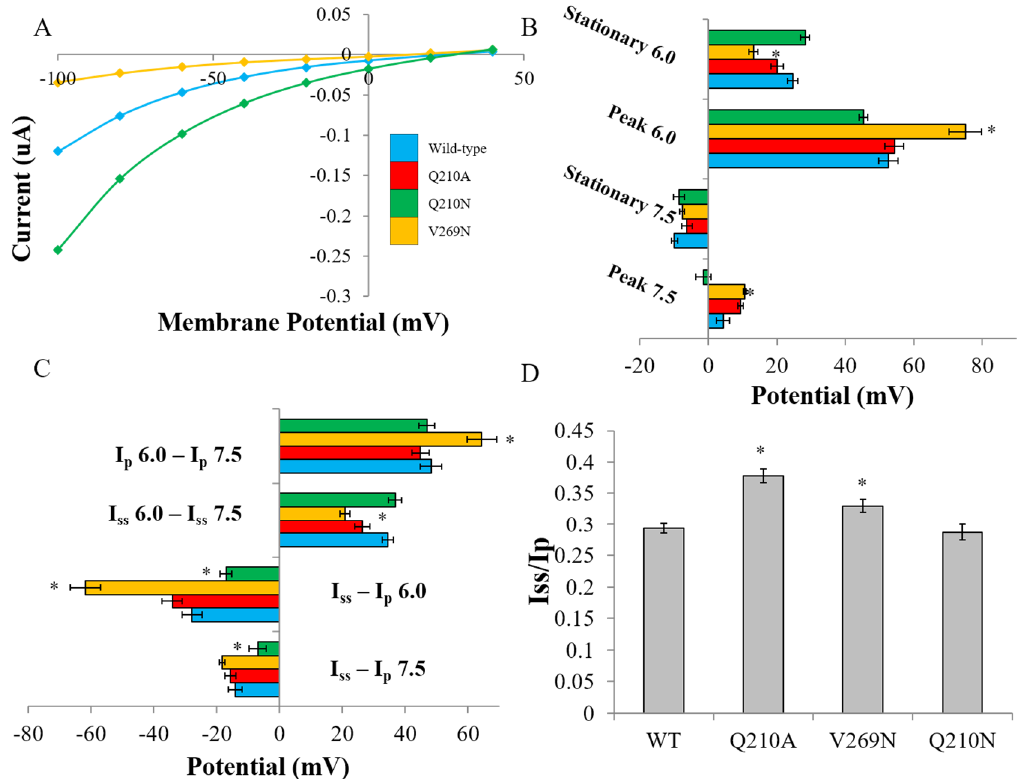
Figure 4. Biophysical characterization of RHM-affecting mutants. ( A ) Representative steady-state current-voltage relationship of select mutants in Na + 6.0 solution. ( B ) Absolute reversal potentials determined at I p and I ss in Na + solutions at either pH 6.0 or 7.5. ( C ) Differences in E rev determined as noted. ( D ) Steady-state to peak current ratios, which are a measure of ChR2 inactivation. Values are reported as the average ± SEM (n = 7–15). Statistically significant values are denoted with * (p < 0.05). WT—blue; Q210A—red; Q210N—green; V269N—orange.